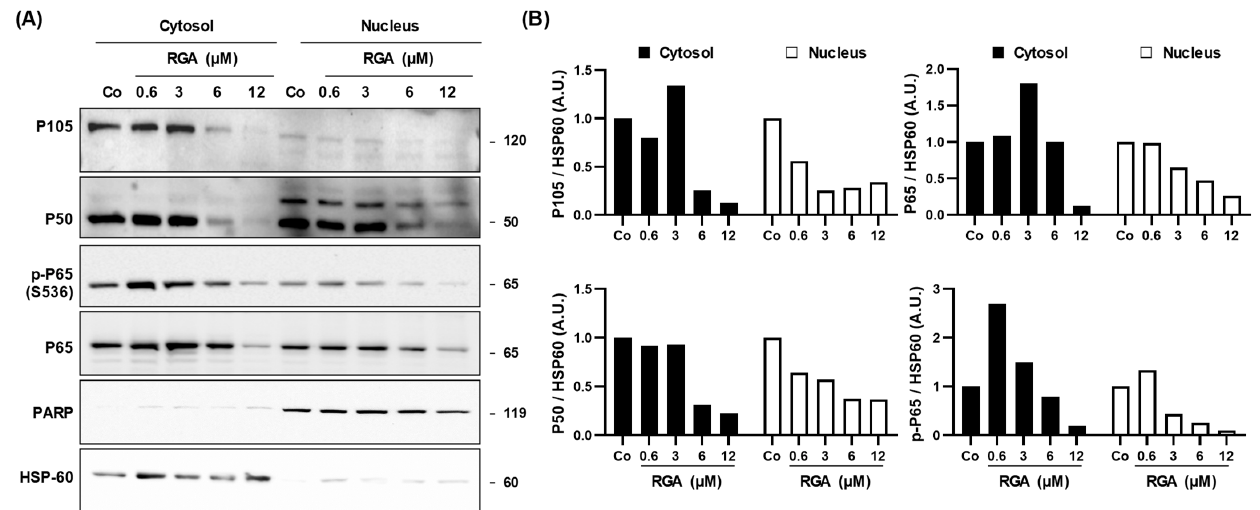
Figure 4. RGA disturbs the translocation of the P65 and P50 dimer subunits of NFkB into the nucleus of ARPE-19 cells. ( A ). Representative blot of P105, P50, P65 protein expression in concentration range of RGA (0.6, 3, 6, 12 µ M)-treated or not (Co) ARPE-19 cells for 24 h. Nuclear fractions and cytosolic fractions are shown from three independent experiments. ( B ) Densitometry quantification of western blotting from the representative nuclear and cytosolic immunoblotting. Data are expressed as the mean fold induction.